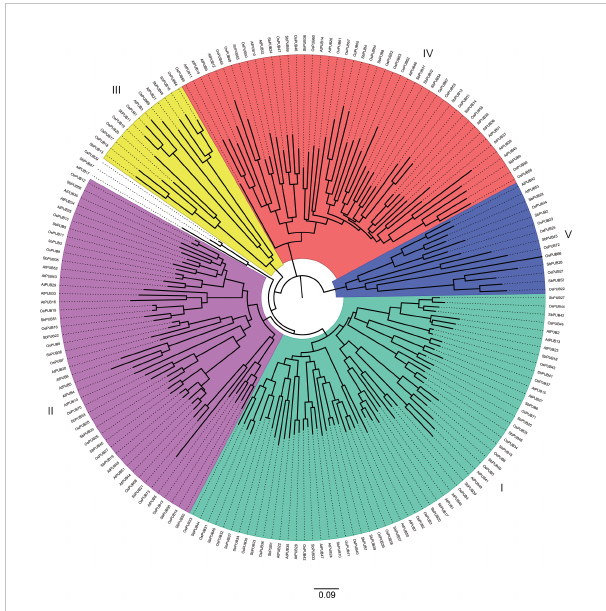
FIGURE 2 Phylogenetic tree analysis of the PUB gene family of sorghum, rice, and Arabidopsis . The multiple sequence alignment of the full-length sequences of these PUB proteins was performed by CluastalX, and the phylogenetic tree was constructed using the software MEGA 7 with the NJ method. All 185 PUB proteins were clustered into fi ve subgroups, designated as Group I -V clades with different colors